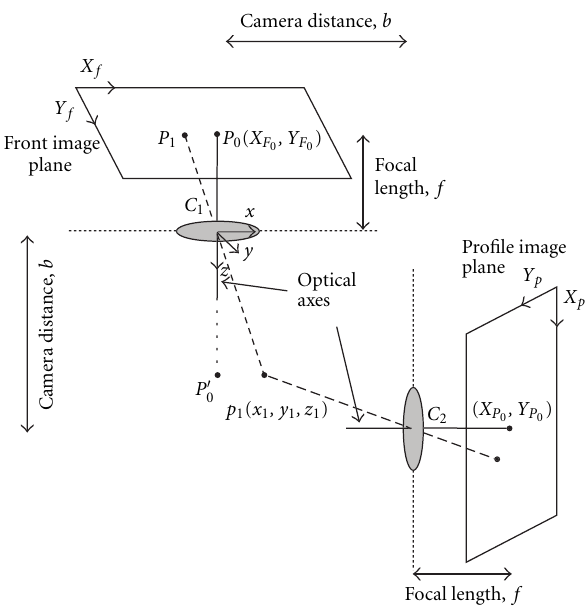
Figure 1: Image acquisition